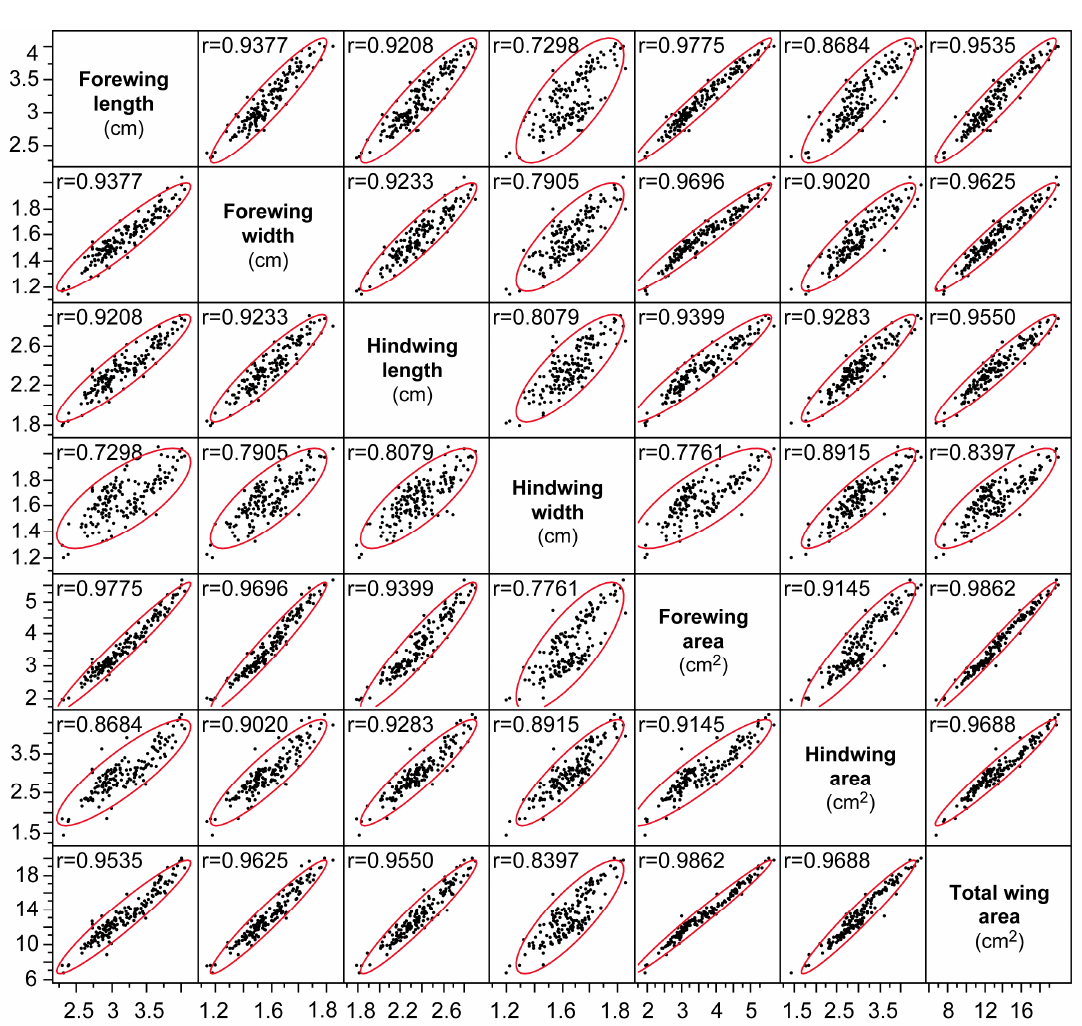
Figure A1. Matrix showing the linear relationships between the morphological parameters of the wings of pine-tree lappet Dendrolimus pini L. for the data collected in the performance test with feeding them with different species of pines. The ellipses for α = 0.95 are marked in red.